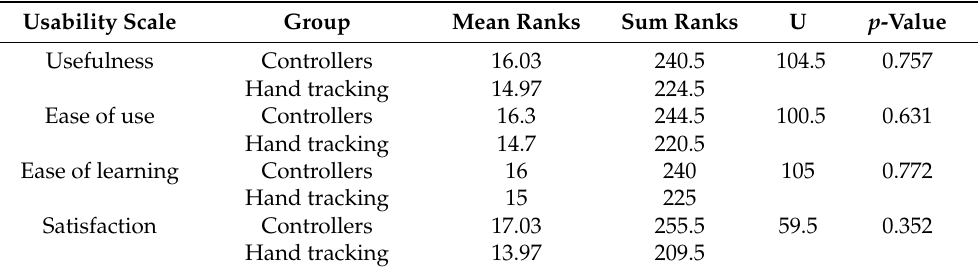
Table 6. Mann–Whitney U test results of learning, training, ease of use, and satisfaction score for VR